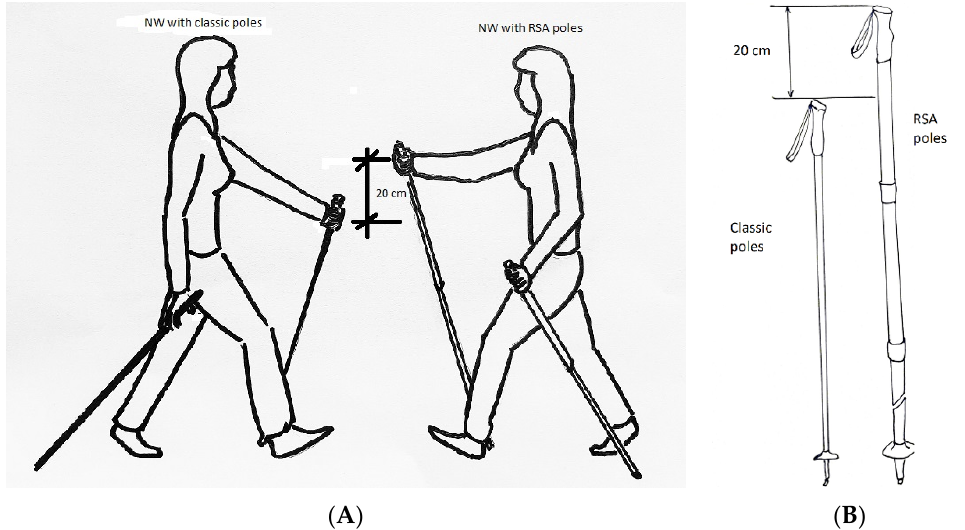
Figure 2. Correct position of upper limbs during Nordic Walking with classic and resistant shock absorber (RSA) poles ( A ), and differences between poles ( B ).